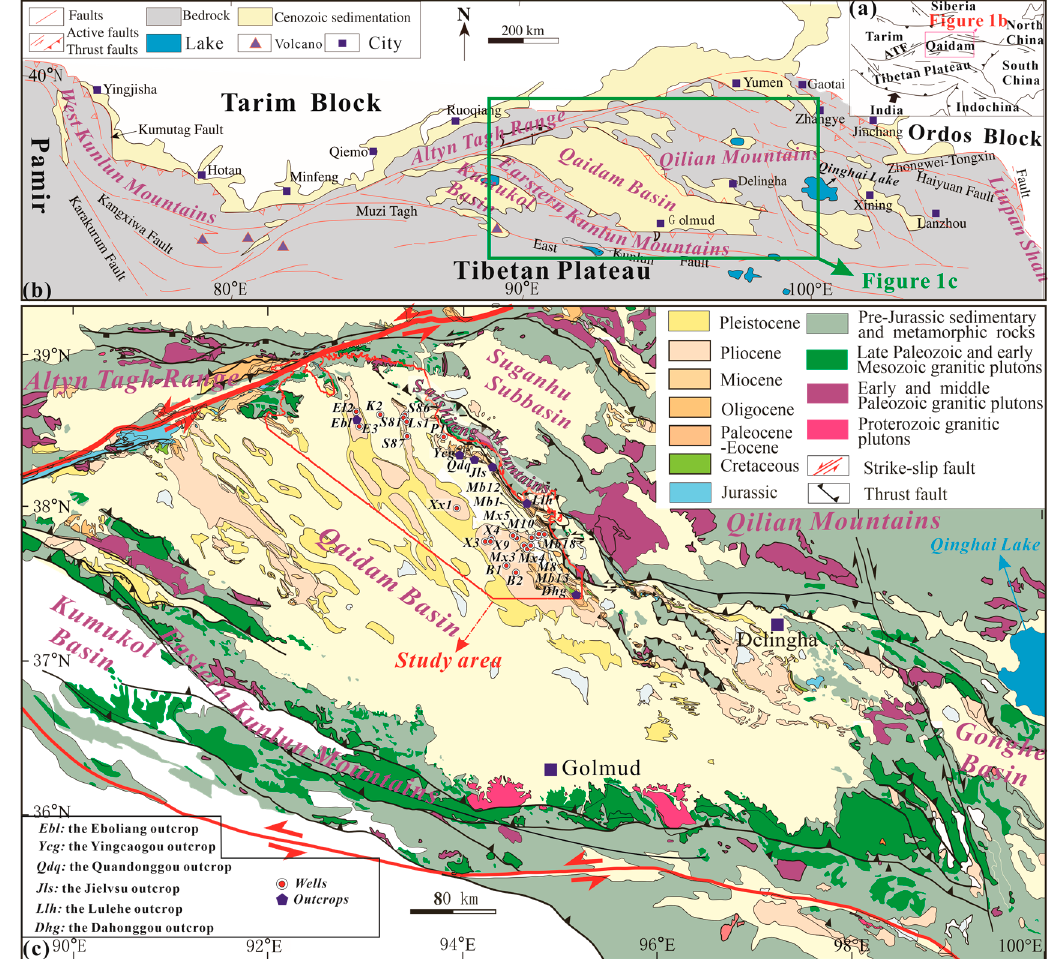
Figure 1. ( a ) Sketch map of the Tibetan Plateau and adjacent regions, showing the major faults. ( b ) Regional tectonic map around the Qaidam Basin located at the northeastern margin of the Tibetan Plateau (modified from Wang et al. 2015 [20]). ( c ) Detailed geological map of the study area in the northern Qaidam Basin (modified from Cheng et al. 2019a [21]).